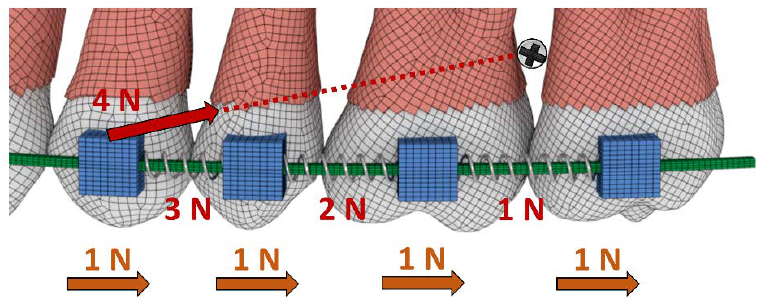
Figure 1. An overview of the mechanics that we propose for distalizing molars efficiently. Each tooth will theoretically receive a distalization force of 1 N.